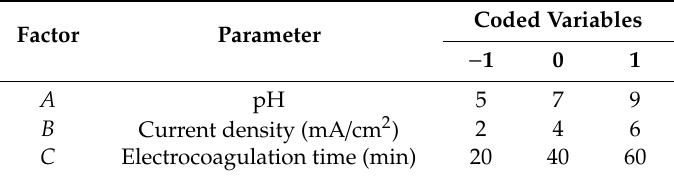
Table 1. Independent variables and their levels.